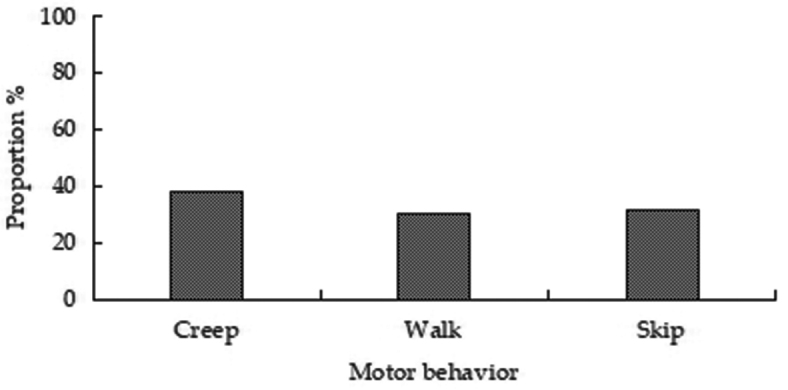
Proportion of motor behaviors of A.
peninsulae.